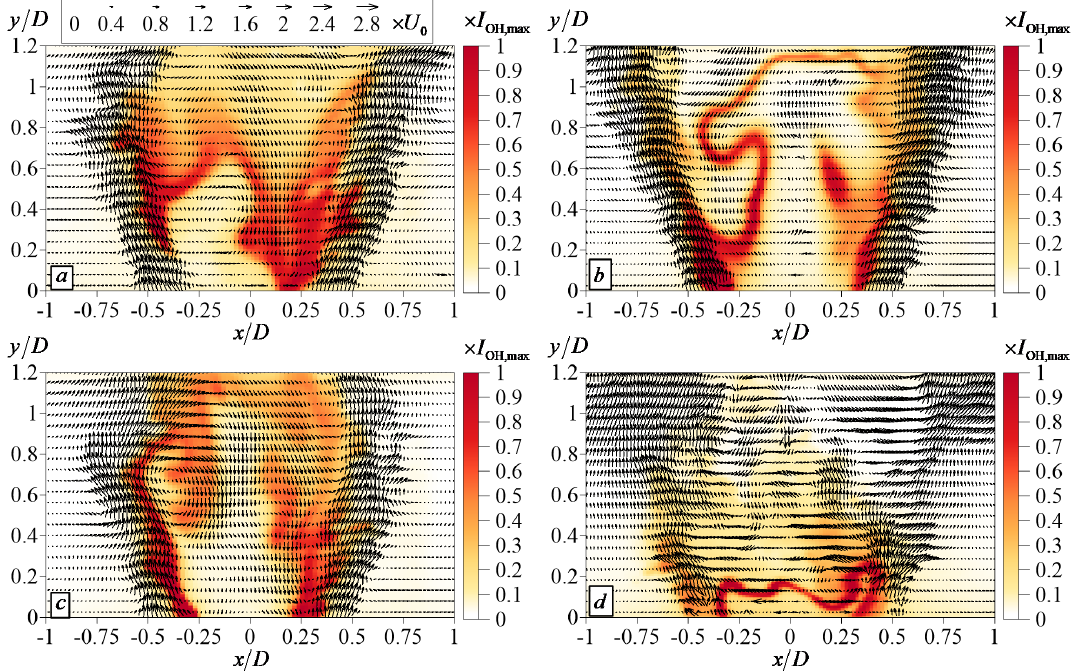
Figure 5. Instantaneous PIV and OH PLIF snapshots for methane ( a , c ) and syngas ( b , d ) flames at normal conditions ( a , b ) and elevated pressure and temperature ( c , d ).